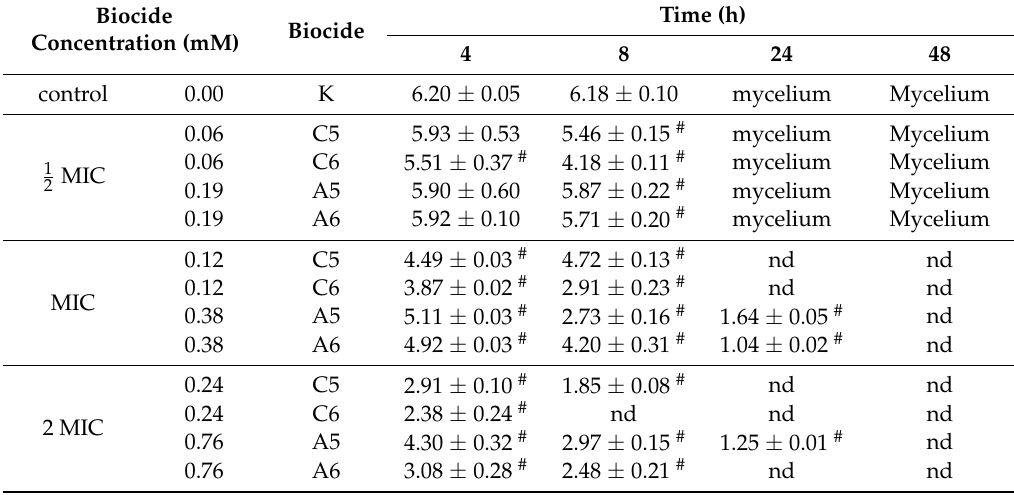
Table 2. Viability of conidia A. brasiliensis ATCC 16404 (log conidia/mL) in medium with microbiocides.